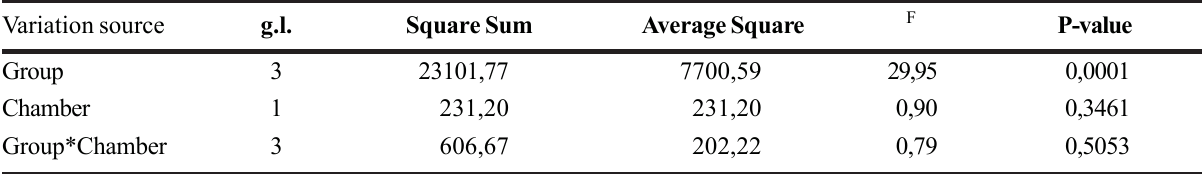
TABLE 2 - Results of the variance analysis (on Ranks) for the variable rupture pressure by liquid distension Variation